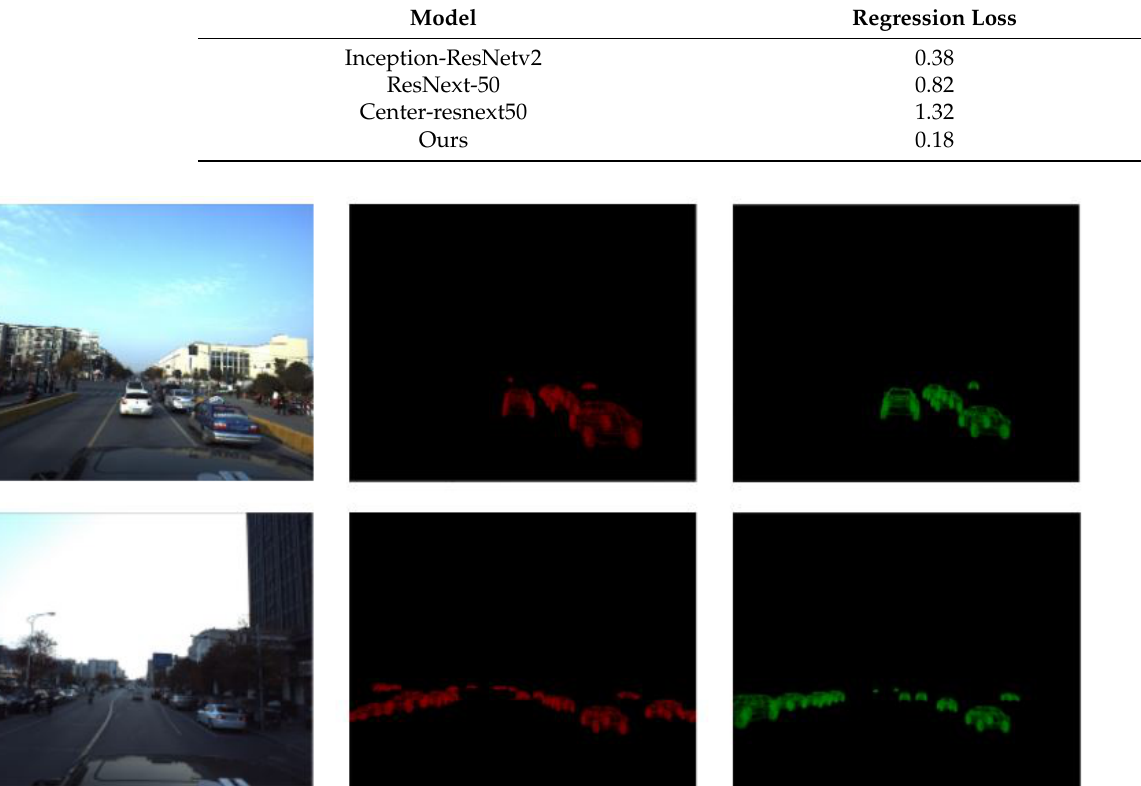
Figure 10. Visualization of model predictions (green) in comparison with the ground truth (red).